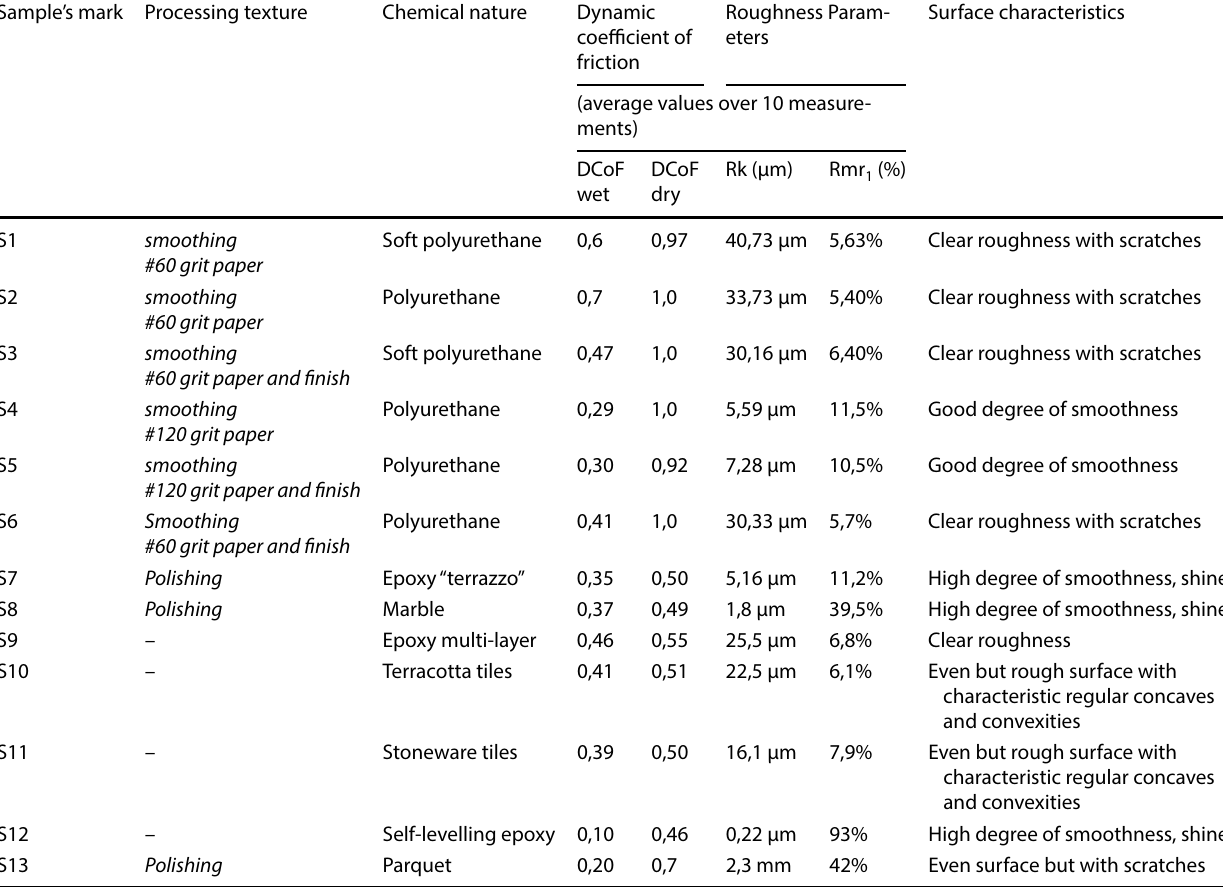
Table 1 Surface characteristics and textures of the analysed samples Sample’s mark Processing